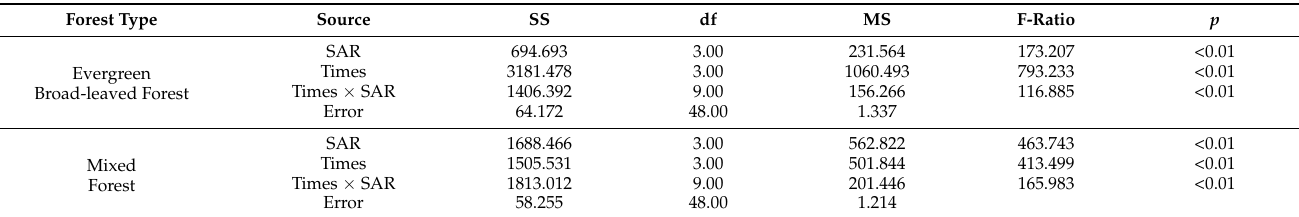
Table 5. ANOVA of soil sucrase